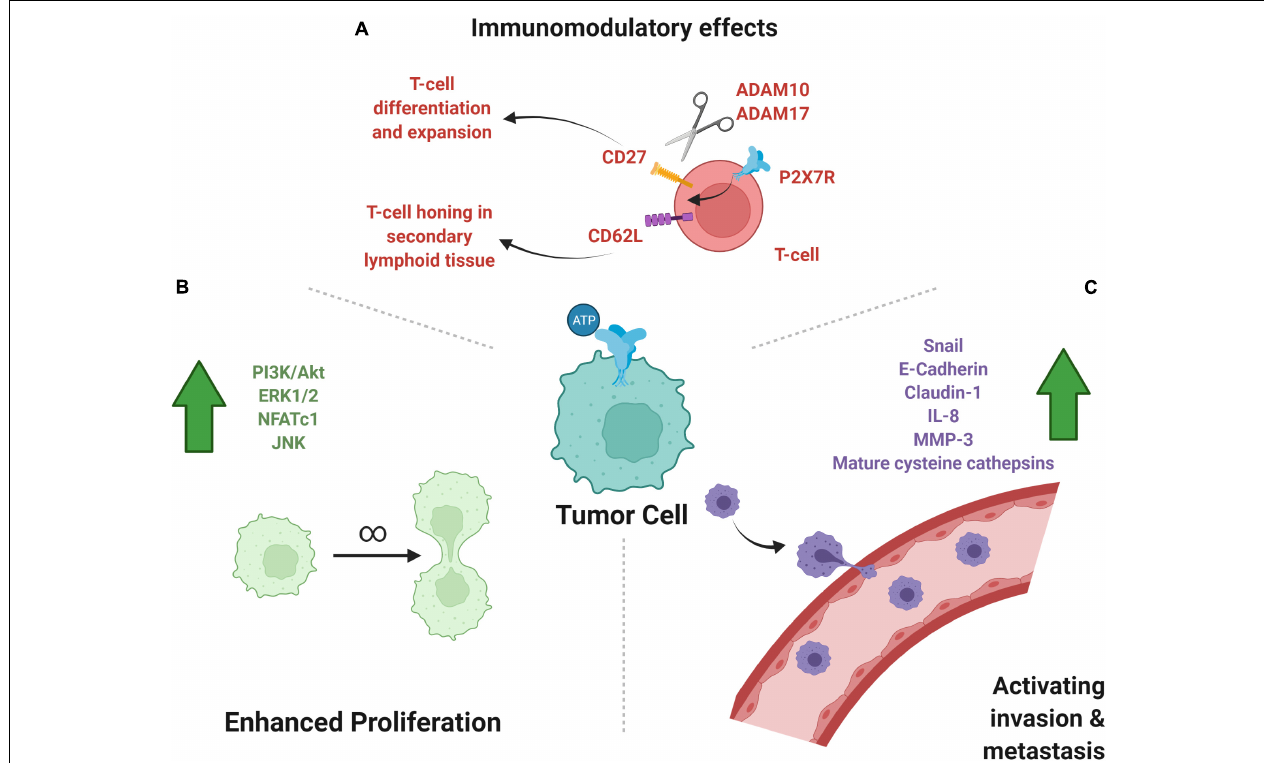
FIGURE 2 | P2-type ionotropic purinoreceptors in cancer growth, metastasis, and immunomodulation. (A) Shown are the anti-tumor, pro-immunomodulatory effects of P2XR activity on immune cells. The effect on T-cells of P2X 7 R activity leads to cleavage of CD27 and CD62L, which help in T-cell clonal expansion and honing to target tissue, respectively. (B) Subcellular pathways upregulated by purinergic signaling may lead to increased cell division and tumor growth, as illustrated. (C) P2X signaling upregulates molecules that favor metastasis, a key prognostic factor into the severity of tumor disease burden. Created with